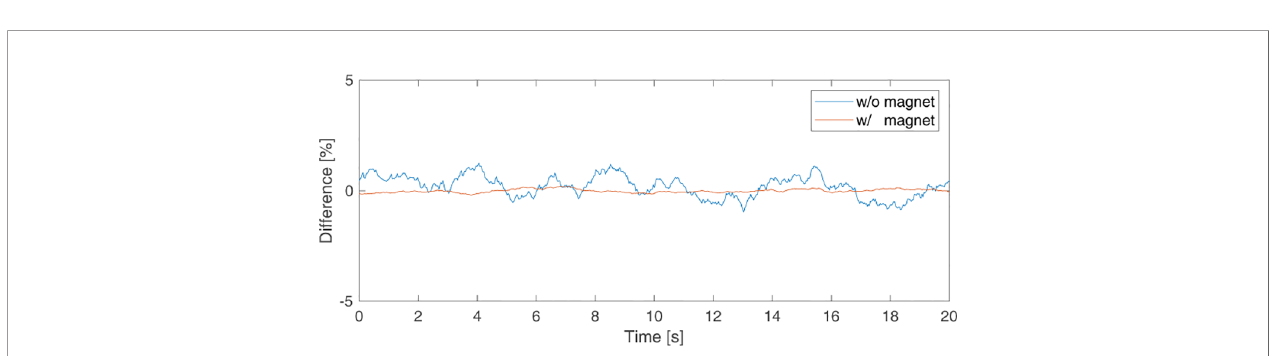
FIGURE 5 | Background signal picked up by the sensor to check for sensor noise when there was (in orange line) and was not (in blue line) a magnet.